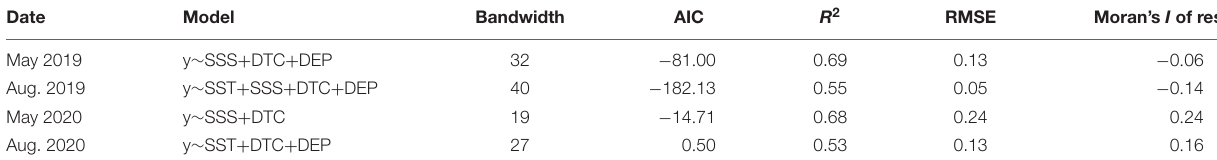
TABLE 2 | Summary of optimal bandwidth and model performance for the geographically weighted regression (GWR) models.